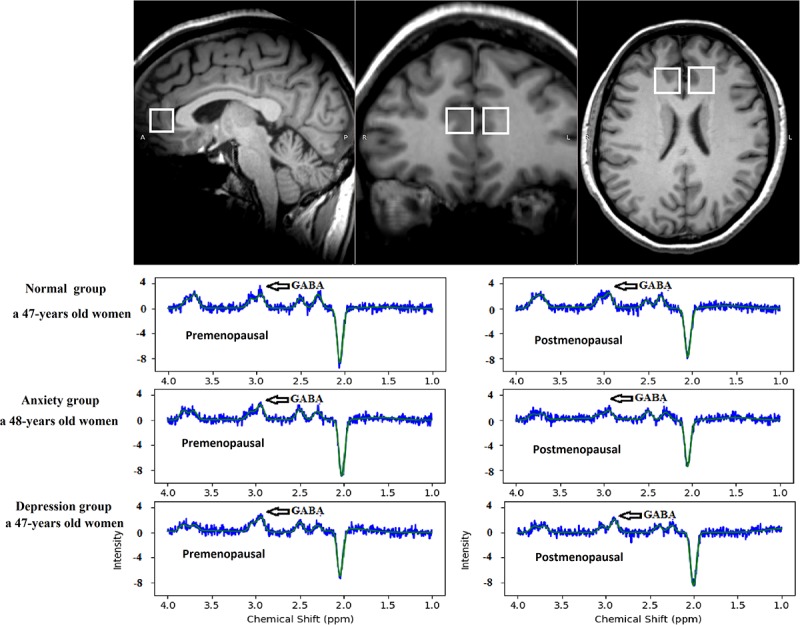
The region of interest in the anterior cingulate cortex on MEGA-PRESS in the axial, sagittal, and coronal planes. TARQUIN edited spectrum GABA in the normal, anxiety, and depression groups. The edited spectrum of the premenopausal and postmenopausal GABA levels located at 3.0 ppm.